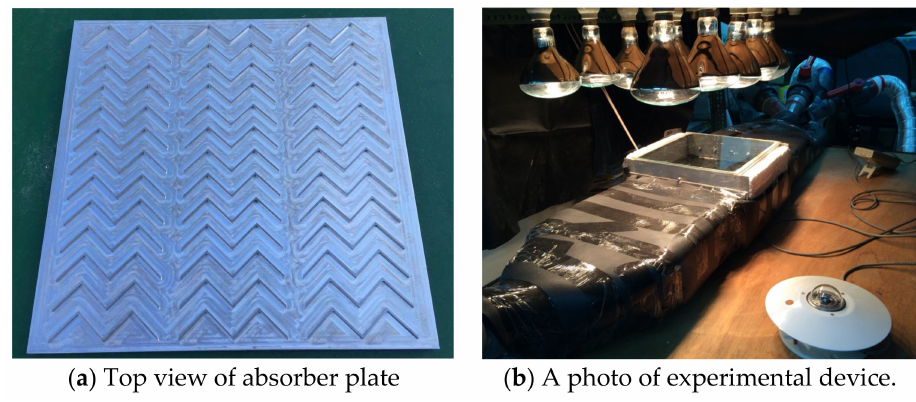
Figure 5. Experimental